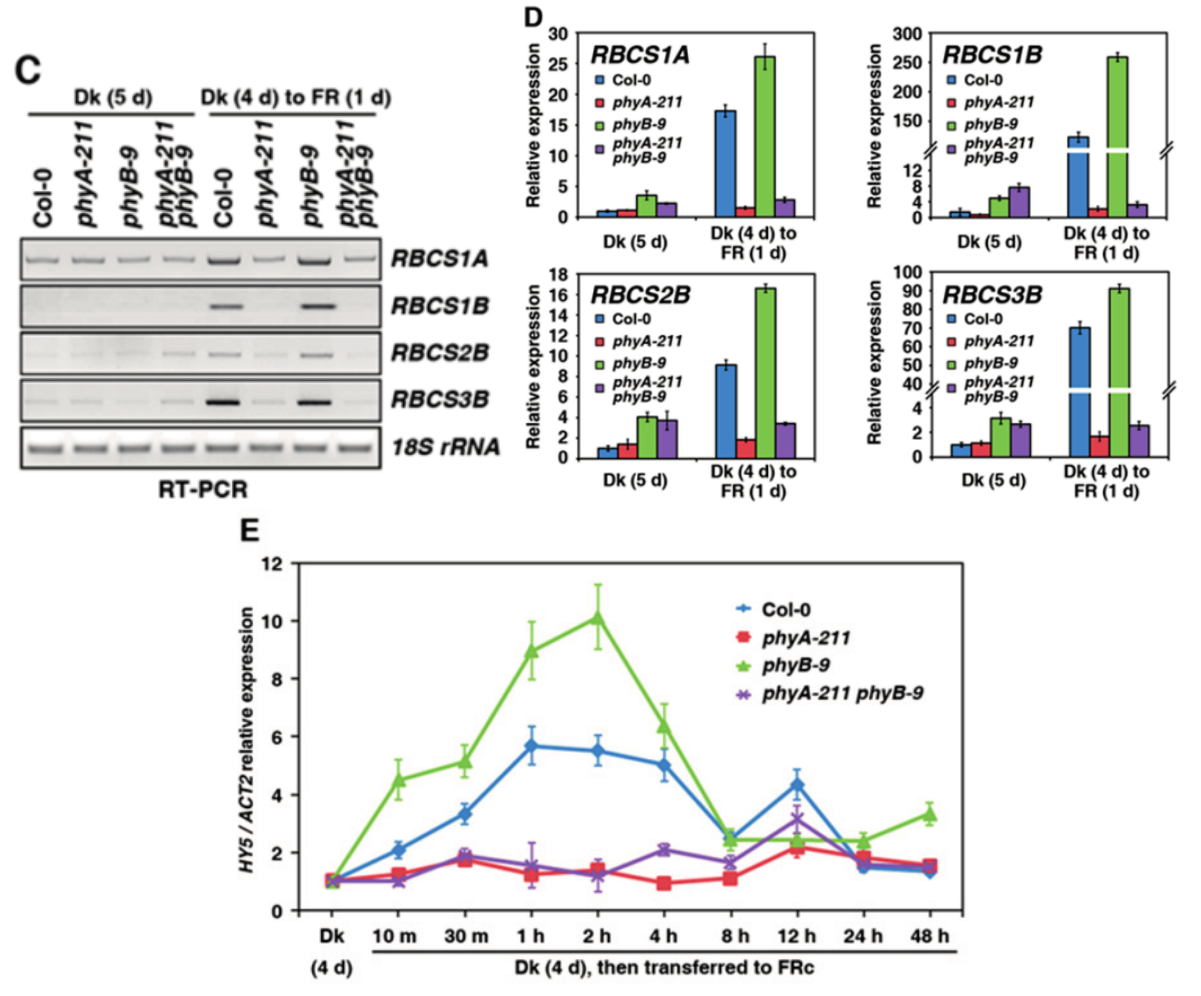
Figure 4. PhyB antagonizes phyA on regulation of seedling development under far-red (FR) light. ( A ) PhyB shows the antagonistic effect on phyA in regulating seedling de-etiolation responses under different FR intensities. The means of three replicates (at least 30 seedlings each replicate) are shown ± SE; ( B ) qRT-PCR analysis of PHYA and PHYB transcript levels in the Col-0 wild type during the Dk/FR transition. Seedlings were grown in darkness for four days and then transferred to FR light (2.5 µmol·m − 2 ·s − 1 ) for 10 min to 48 h. Error bars indicate the SD of three replicates; RT-PCR ( C ) or qRT-PCR ( D ) analysis of RBCS genes in seedlings of the WT Col-0, and phyA-211 , phyB-9 and phyA-211 phyB-9 mutants grown in darkness for 5 days or in darkness for 4 days then transferred to FR light (18.1 μ mol·m − 2 ·s − 1 ) for 1 day. RT-PCR of the 18S RNA gene is shown at the bottom as a positive control. Error bars indicate the SD of three replicates; and ( E ) qRT-PCR analyses of HY5 transcripts in seedlings of the WT Col-0, and phyA-211 , phyB-9 and phyA-211 phyB-9 mutants; Seedlings were grown as ( A ). Error bars indicate the SD of three replicates. We next sought to determine the antagonistic action between phyA and phyB in response to FR light by measuring transcript levels of four members of the RBCS gene family. The WT, phyA-211 , phyB-9 , and phyA-211 phyB-9 seedlings were grown in the dark for four days, then transferred to FR for 24 h, at which point the RBCS transcript levels were determined by RT-PCR and real-time qPCR. As shown